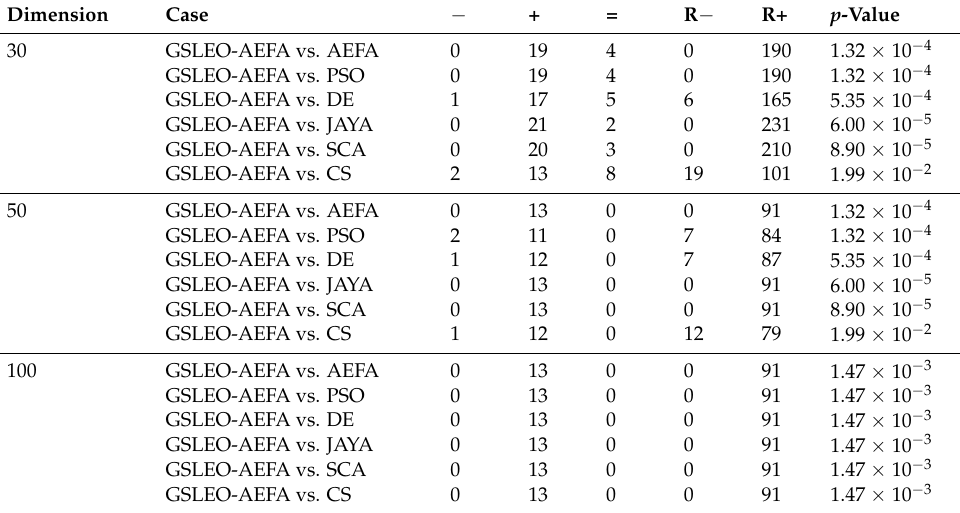
Table 6. Wilcoxon test analysis results.